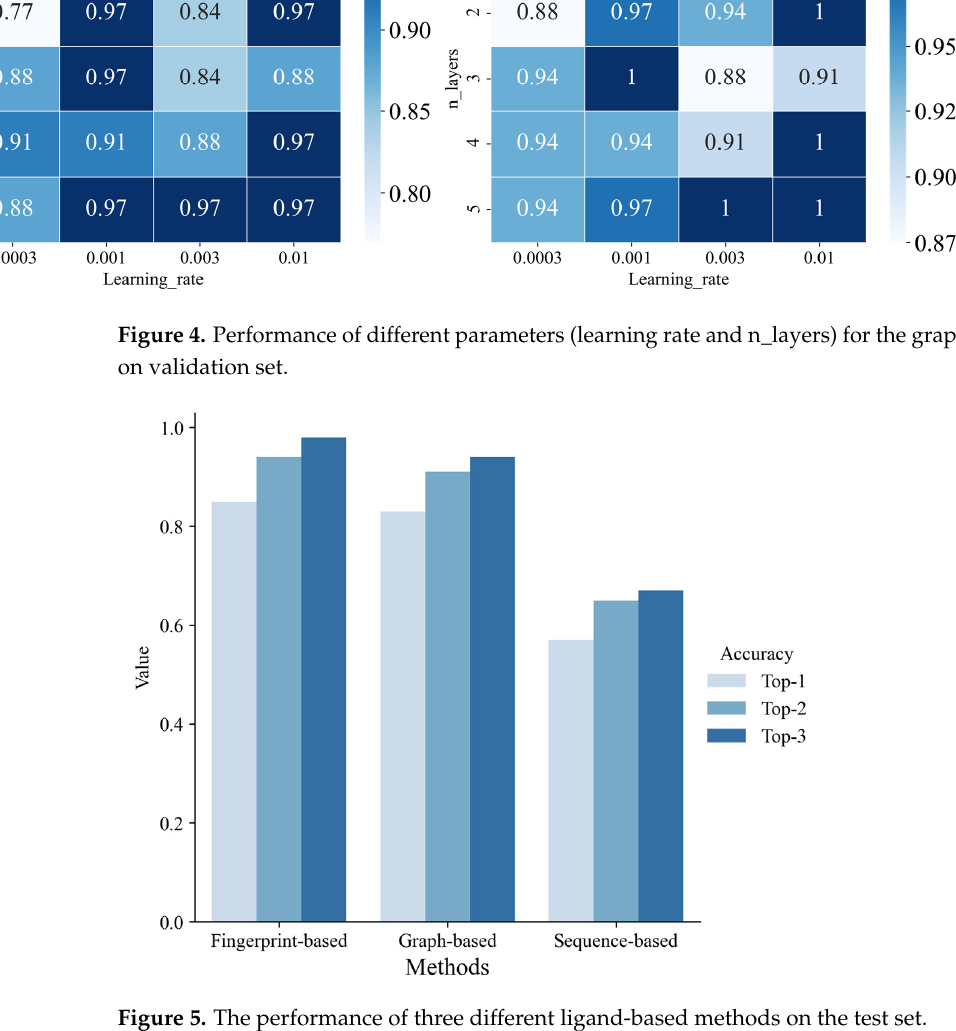
Figure 5. The performance of three different ligand-based methods on the test set.